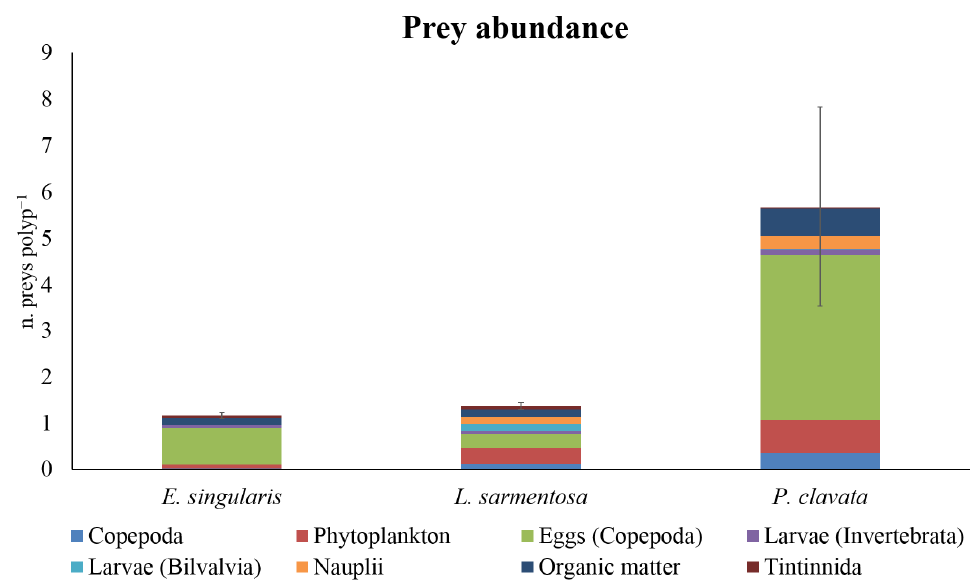
Figure 4. Prey abundances in the fed polyps of the three investigated species. The results of the PERMANOVA revealed a significant D × S term, indicating dif- ferences among the three species at varying of the sampling days (Table 5), as showed in detail by pairwise analyses (Table